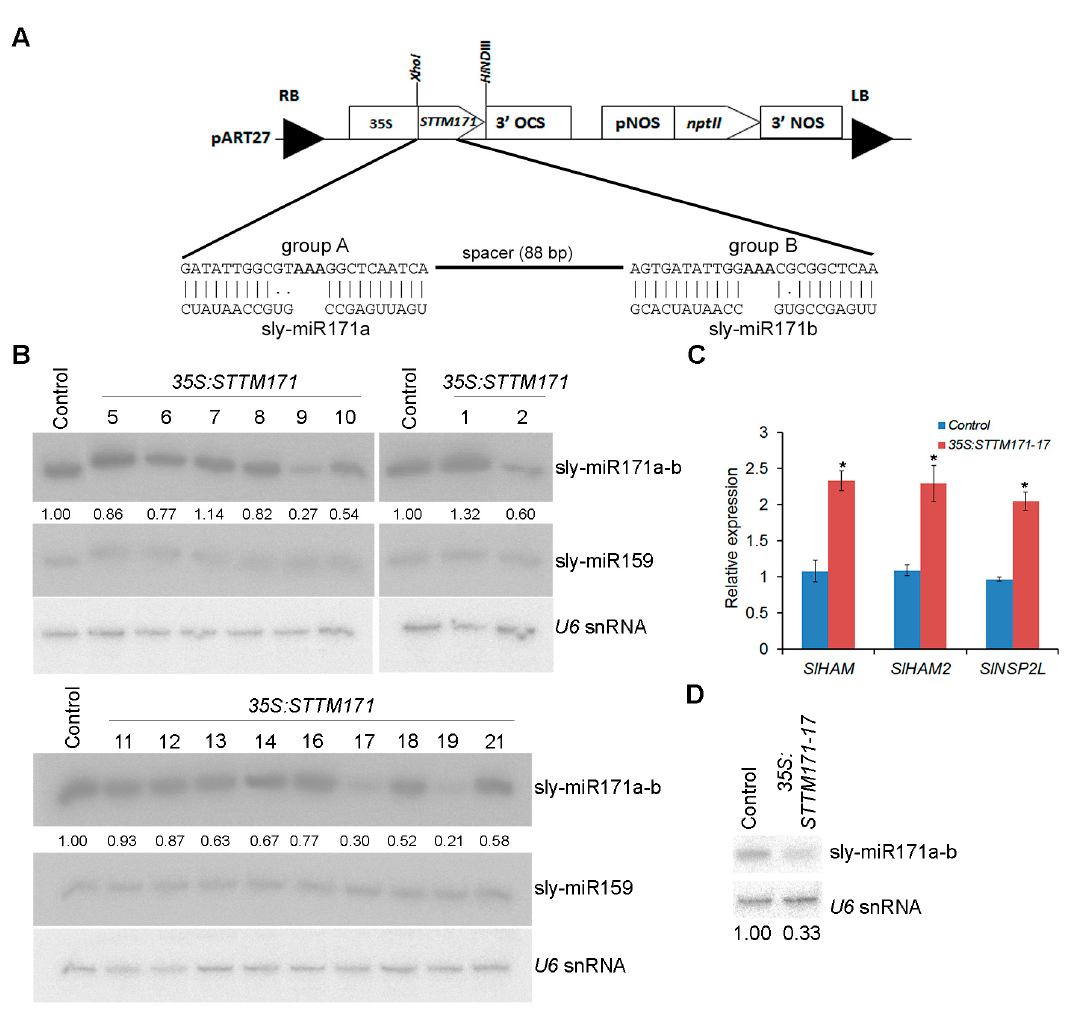
Figure 2. Generation of transgenic STTM171 tomato with reduced sly-miR171 levels. ( A ) A scheme of the Short Tandem Target Mimic construct used for tomato M82 transformation. The Watson–Crick pairings between group A and B target mimic sites and sly-miR171 representative members are shown in the expanded region. ( B ) RNA gel blot analysis of sly-miR171 levels in indicated transgenic T0 plants. Total RNA (5 µg) from leaves was probed by sly-miR171a (sly-miR171a-b), sly-miR159 and U6 antisense probes. Sly-miR171 expression levels were determined after normalization to sly-miR159 and U6 snRNA by geometric averaging and are indicated below. ( C ) RT-qPCR analysis of sly-miR171 target transcripts in RNA from young leaves of one-month old T2 35S:STTM171-17 plants. TIP41 expression values were used for normalization. Error bars indicate ± SD of three biological replicates, each measured in triplicate. Asterisks indicate significant difference relative to 35:GFP control plants (Tukey–Kramer multiple comparison test; p < 0.01). ( D ) RNA gel blot analysis of sly-miR171 in 5 µg total RNA from the samples analyzed in C. The blots were probed with sly-miR171a (sly-miR171a-b) antisense probe. Sly-miR171 expression levels were determined after normalization to U6 snRNA and are indicated below.